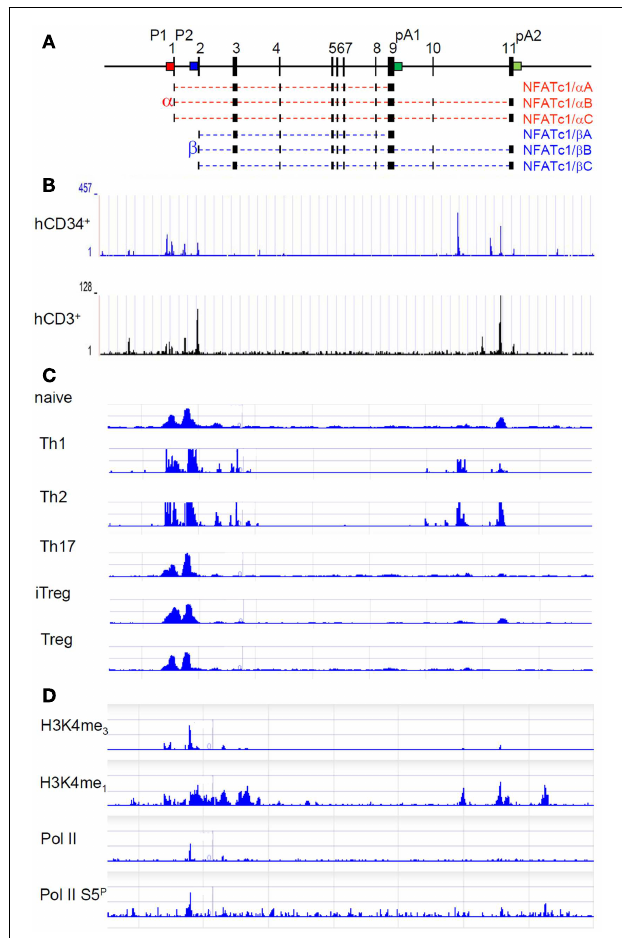
FIGURE 1 | Molecular organization and epigenetic marks of the Nfatc1 gene . (A) Exon–intron structure of the murine Nfatc1 gene.The two promoters P1 (red) and P2 (blue) and the two poly A addition sites pA1 and pA2 (both in green) are indicated. In intron 10, an enhancer for the Nfatc1 induction in lymphocytes is located, and at the 3 (cid:48) end of intron 1, an enhancer was described for controlling Nfatc1 transcription in endocardial cells of the developing heart (13). (B) Occurrence of DNase I hypersensitive sites in the human NFATC1 gene in CD34 + hematopoietic progenitor cells and CD3 + T cells (see http://nihroadmap.nih.gov/epigenomics (14). Note the existence of DNase I hypersensitivity over the promoter region and the intron 10 in which we identified an enhancer for the induction of Nfatc1 gene (Patra et al., in preparation; see below). (C) Epigenetic H3K4me3 marks – as indicator for regulatory elements, which are either poised for or active in transcription (15) – at the promoter region and intron 10 sites inTh1 andTh2 cells (16). Note the appearance of H3K4me3 mark around the P1 and P2 promoters in all types ofT cells, whereas the occurrence of H3K4me3 mark in intron 10 is restricted toTh1 andTh2 in which we observed a strong Nfatc1 induction upon cellular activation (17). (D) Accumulation of RNA polymerase II (pol II) and of epigenetic marks on the Nfatc1 gene in DP thymocytes (18). Note the appearance of pol II at promoter P2 and of enhancer mark H3K4me1 in the promoter region and intron 10.